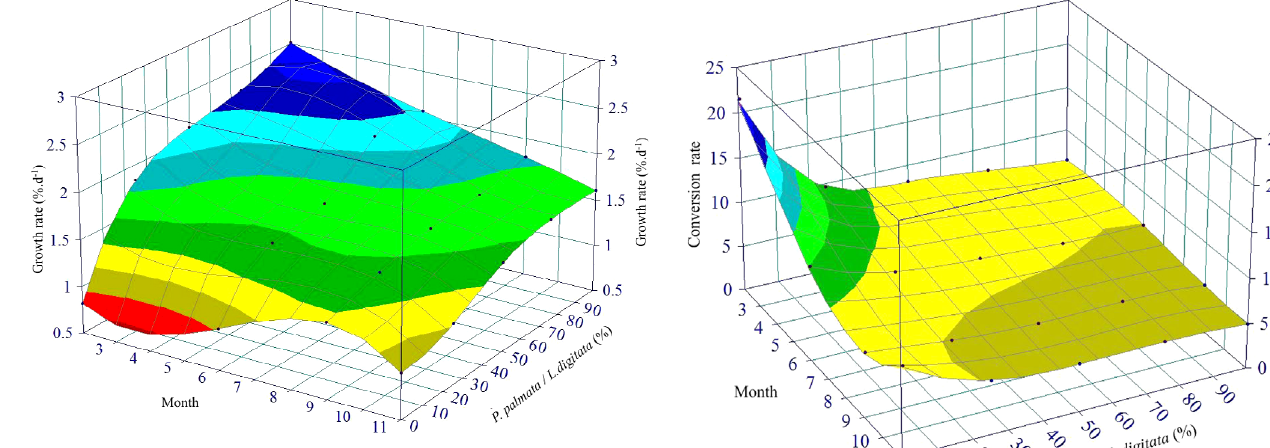
Fig. 4. Model of the weight growth rate (%.d (cid:3) 1 ) by P. palmata / L. digitata ratio and the time of year [ r 2 =0.95, F-stat = 23.70; SGR = a þ b lnx þ cy þ d(lnx) 2 þ ey 2 þ fylnx þ g(lnx) 3 þ hy 3 þ Fig. 5. Model of the food conversion rate according to P. palmata / L. digitata ratio and the time of year [ r 2 =0.97; F-stat =39.70; z = (a þ bx þ cx 2 þ dy þ ey 2 þ fy 3 )/(1 þ gx þ hx 2 þ ix 3 þ jy) (with x = month; y = P.palmaria/L.laminaria (%); a =5,4714; b = 1,1188; c = (cid:3) 0,1143; d = 0,0407; e =0,0015; f = (cid:3) 9,25E-06; g = (cid:3)